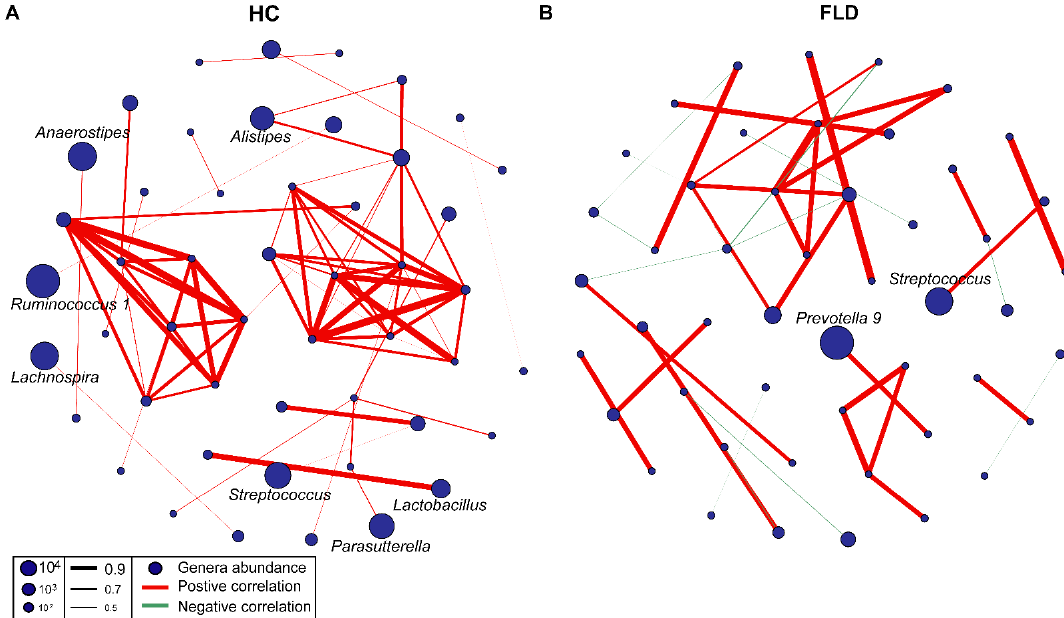
Figure 2. Microbial network comparison between children with NAFLD and healthy children. ( A , B ) The microbial network for children with NAFLD and healthy children. ( A , B ) The microbial network for children with NAFLD and healthy